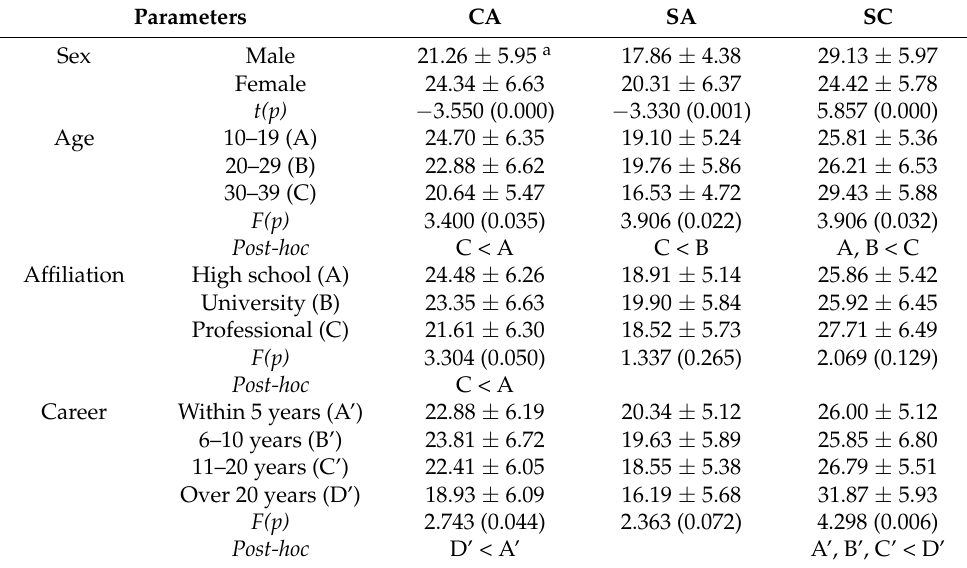
Table 3. Comparison of competitive state anxiety ( n =